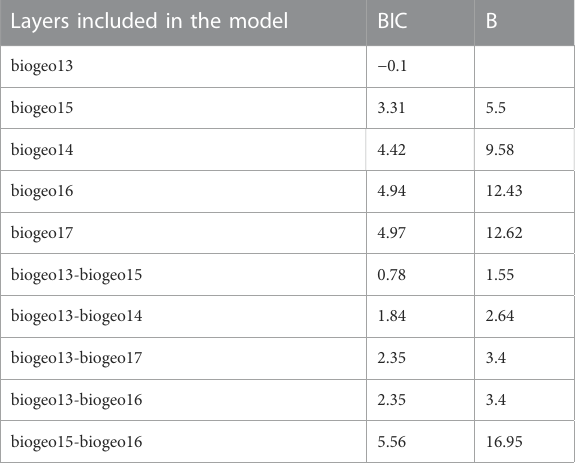
TABLE 4 Bayesian Information Criterion (BIC) values and Bayes factors (B) estimatedbytheheuristic